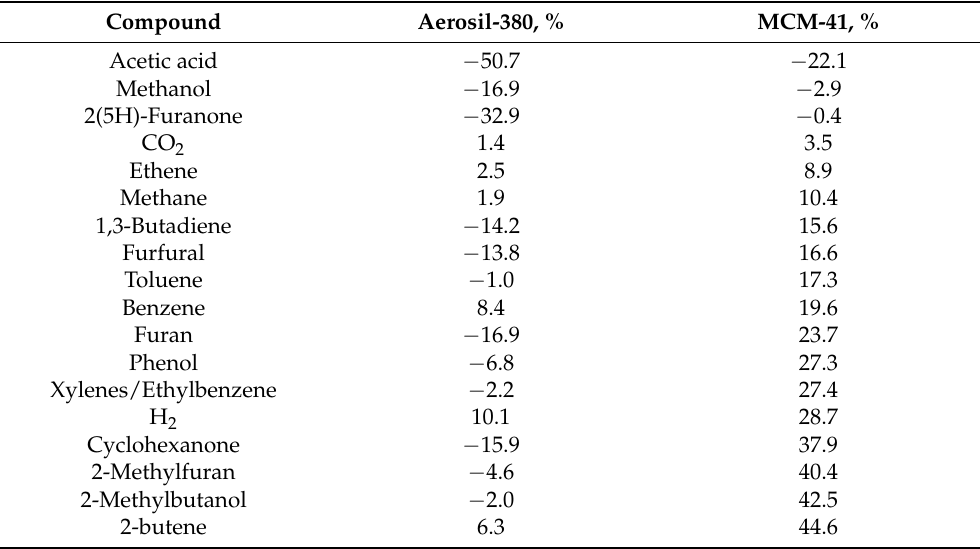
Table 5. Increase or decrease in cumulative production of compounds due to the presence of silica catalysts during ASB pyrolysis.